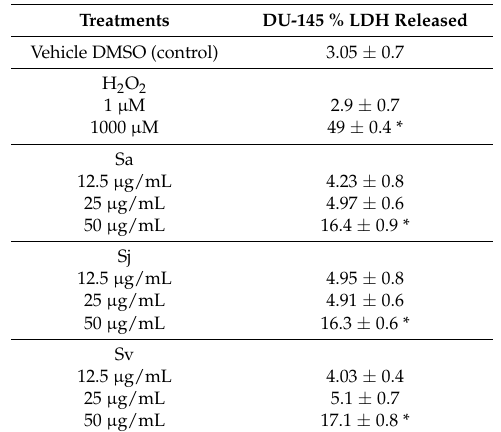
Table 1. Lactate dehydrogenase (LDH) release in DU-145 cells untreated and treated with the essential oils from Sa, Sj and Sv at different concentrations for 72